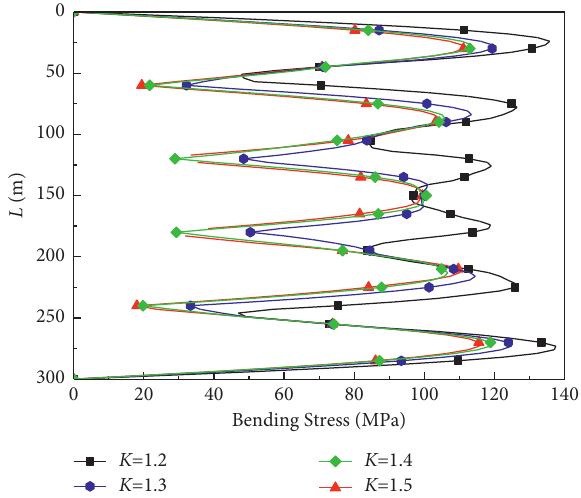
Figure 6: VIV bending stress distribution of the riser under dif- ferent top